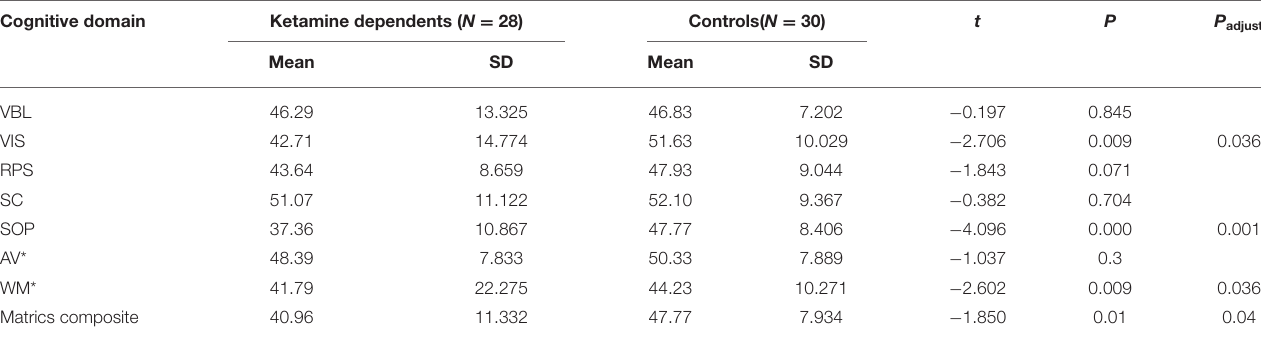
TABLE 2 | Comparison of cognitive performance of MATRICS consensus cognitive battery (MCCB) between chronic ketamine users and healthy controls (HCs). Cognitive